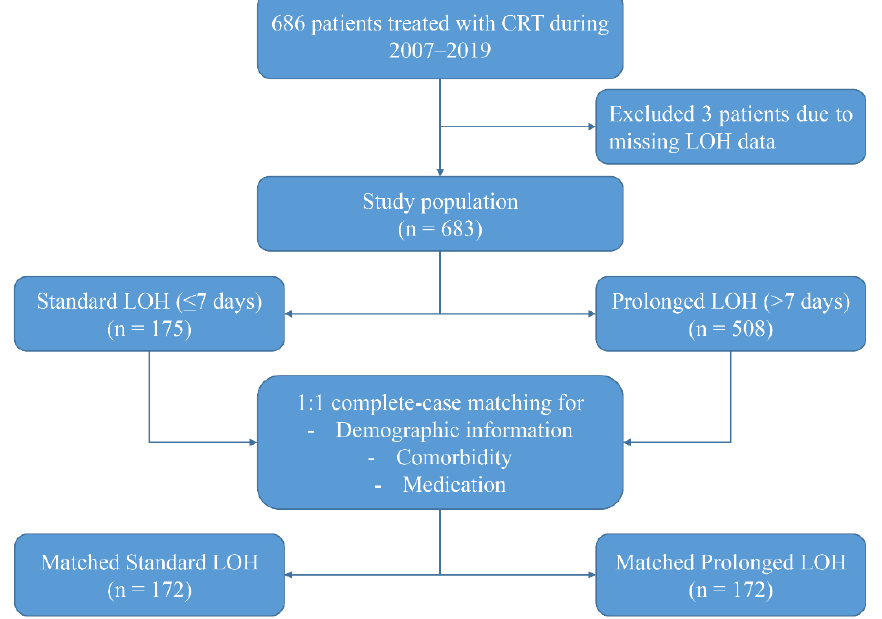
Figure 1. Study Population.